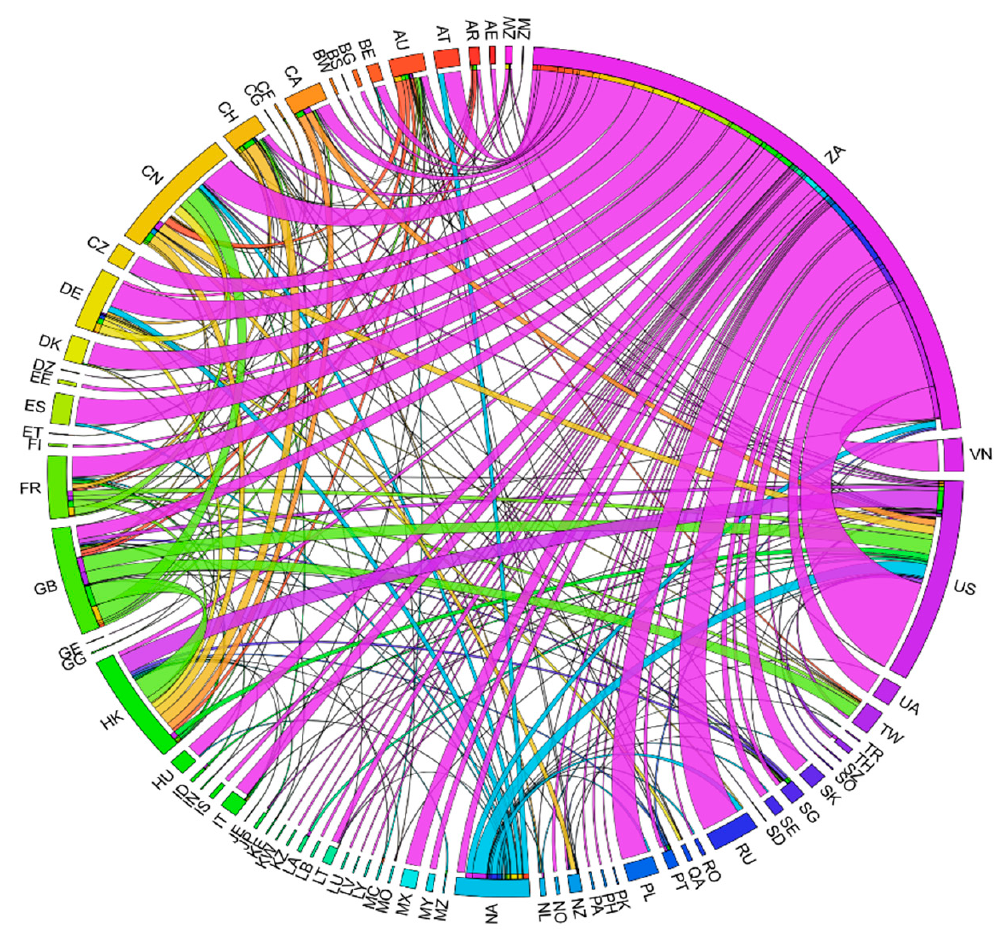
Figure 3. Aggregated routes of rhino trade cases, 2007–2017 (The CITES Trade Database).